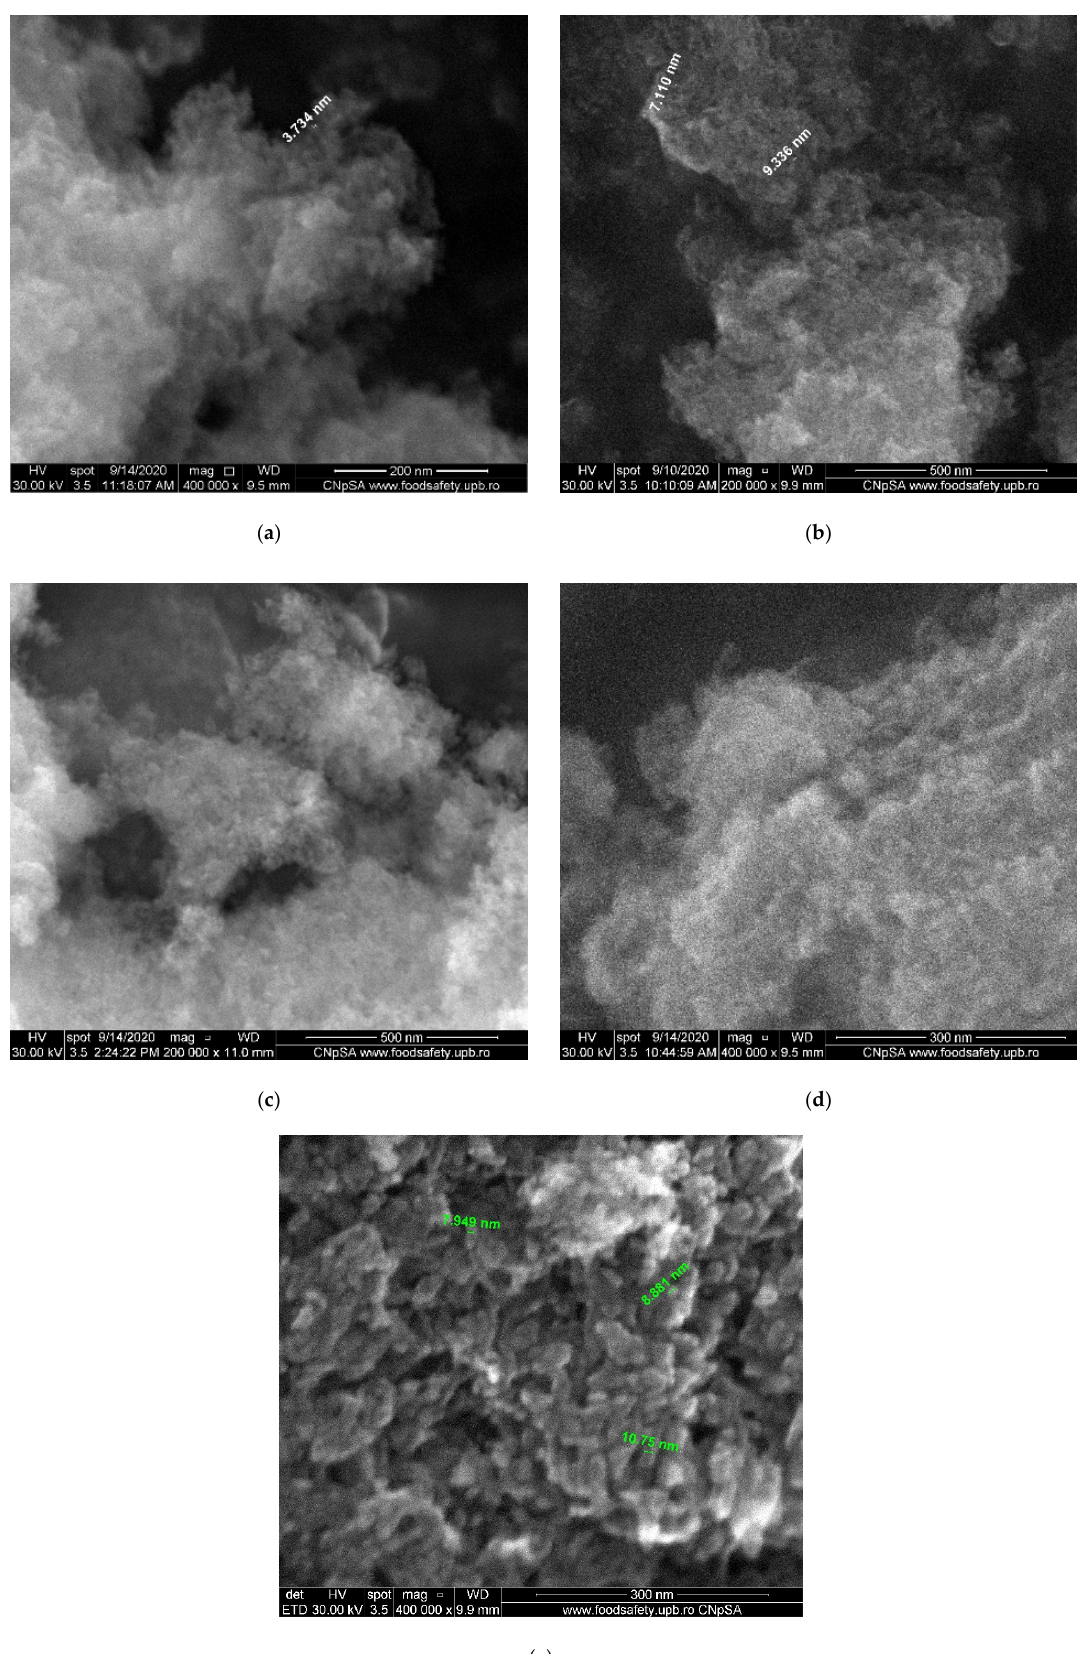
Figure 6. SEM images of Ca 10 − x Tb x (PO 4 ) 6 (OH) 2 ( a ) x = 0.05; ( b ) x = 0.1; ( c ) x = 0.25; ( d ) x = 0.5; ( e ) x = 1. 3.5. TEM Investigation In Figure 7, TEM images of hydroxyapatite doped with terbium ion for x = 0.05 (Fig- ure 7a), x = 0.25 (Figure 7b) and x = 1 (Figure 7c) are shown. The bright field TEM images show a rod-like morphology of the particles specific to hydroxyapatite. ( c ) Figure 7. TEM images, for x = 0.05 ( a ) , x = 0.25 ( b ), x = 1 ( c ). The TEM micrographs confirmed what was also shown in SEM images, in terms of the tendency to form agglomerates because of the nanometric dimensions of the particles and the decrease in particle size with increasing terbium content. 3.6. UV-Vis and PL Spectra The UV-Vis spectra of terbium-doped hydroxyapatite powders from Figure 8a shows two shoulders at 242 nm and 259 nm. The intensity of band observed at 242 nm increases